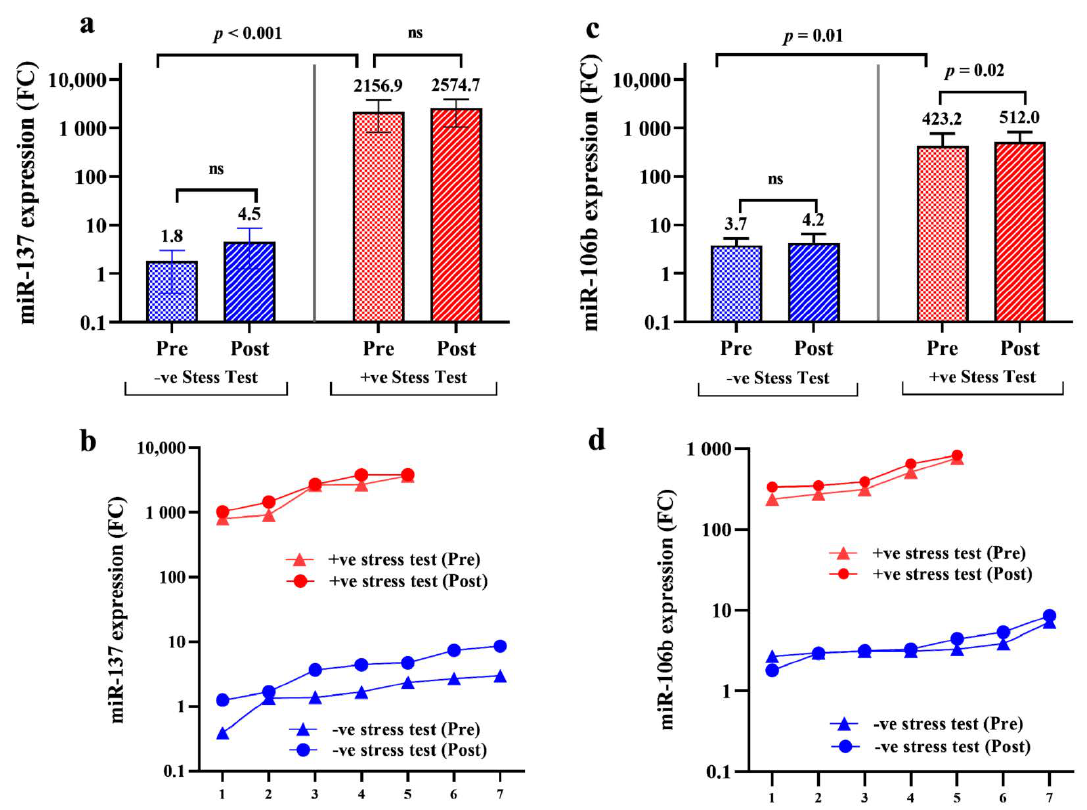
Figure 3. Bar chart graph illustrates miR-137 ( a ) and miR-106b-5p ( b ) expression levels in patients with chest pain and suspected of CAD; miRNA expression levels were measured before stress test-induced ischemia, “pre-stress test” and 30 min “post-stress test”; the “expression patterns” of Nourin miRNAs, miR-137 ( c ) and miR-106b-5p ( d ) were plotted for positive stress test patients “pre-stress test” and 30 min “post-stress test” and compared to patients who showed negative results in order to investigate the computability of Nourin miRNAs level and stress test results; p < 0.05 considered significant; ns: no-significant